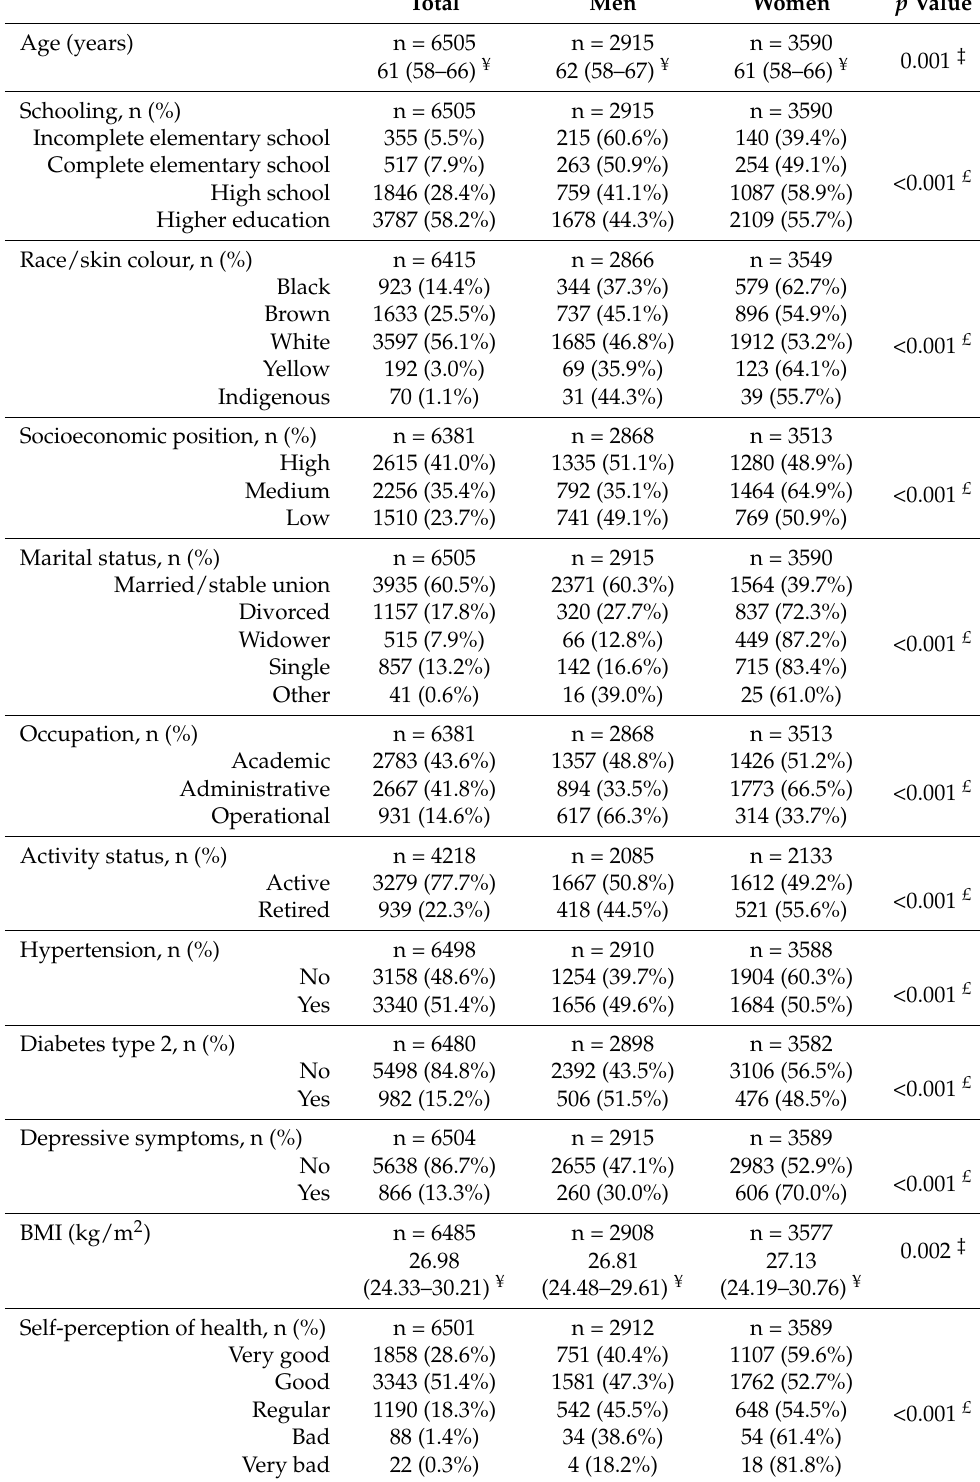
Table 1. Characterization of the sample stratified by sex. ELSA-Brasil (2012–2014).